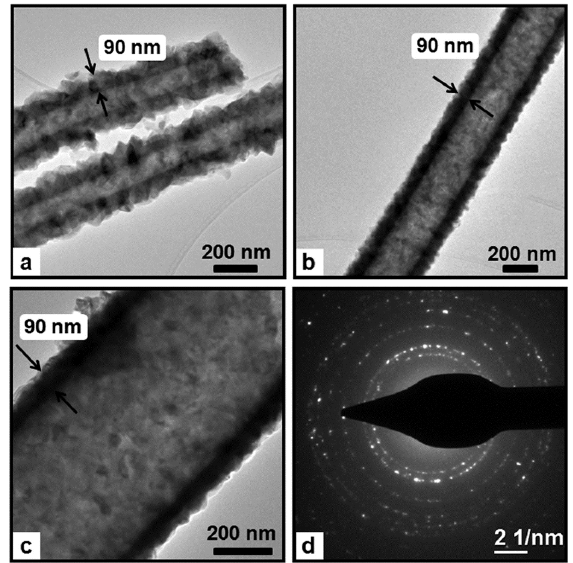
Figure 3. Representative TEM images of ( a ) 8%-nylon 6,6/FA-ZnO, ( b ) 5%-nylon 6,6/HFIP-ZnO, ( c ) 8%-nylon 6,6/HFIP-ZnO core − shell nanofibers; ( d ) representative SAED pattern of the core − shell nylon 6,6-ZnO nanofibers (8%-nylon 6,6/HFIP-ZnO NF). (Reprinted from the work of Kayaci et al. [31]. Copyright 2012, with permission from the American Chemical Society).